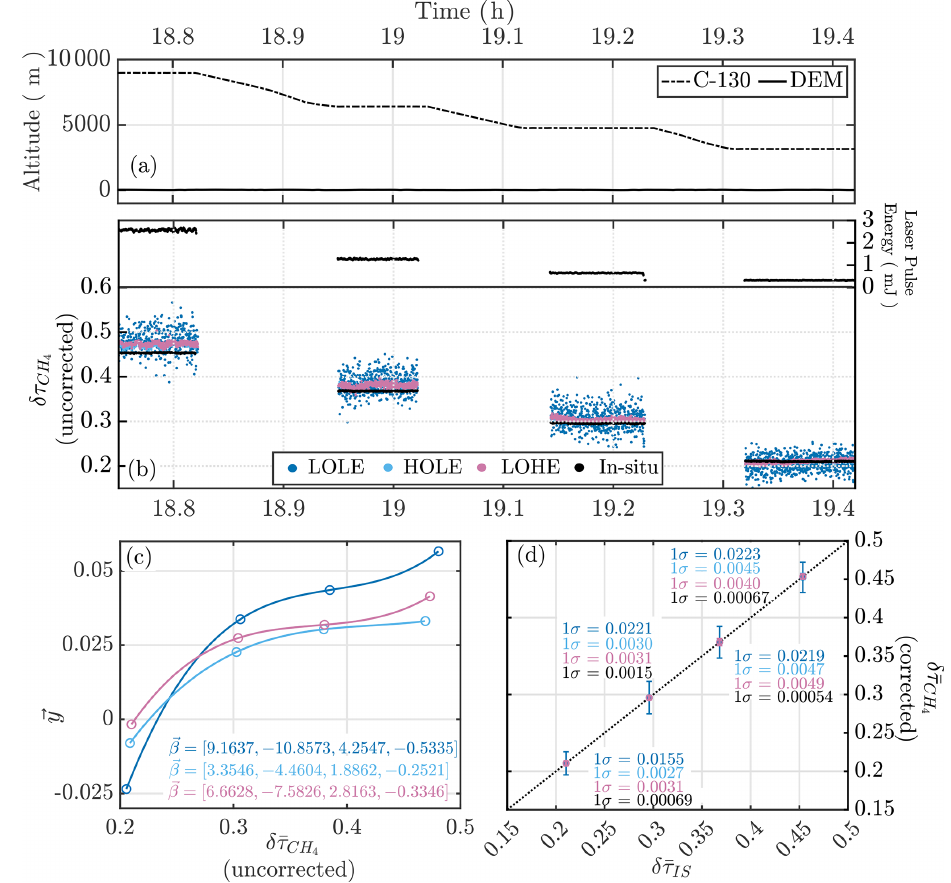
Figure 6. Summary of the 11 June stair-step maneuver in eastern Virginia (VA) and steps to calculate a DAOD correction. (a) Flight profile and digital elevation model height. (b) The 2Hz HALO DAOD for all gains and the in situ-derived DAOD. The transmit pulse energies are shown indicating variable attenuation to maintain a constant surface signal amplitude. (c) Fractional differences between the mean HALO and in situ-derived DAODs for the different gains. (d) Bias-corrected HALO DAOD compared to the in situ-derived values. Final 1 σ SD values for each point are shown with in situ in